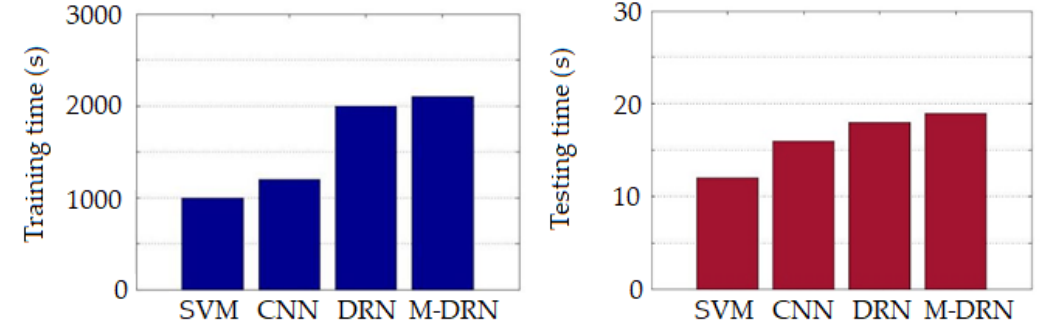
Figure 15. Operation time comparison for di ff erent network